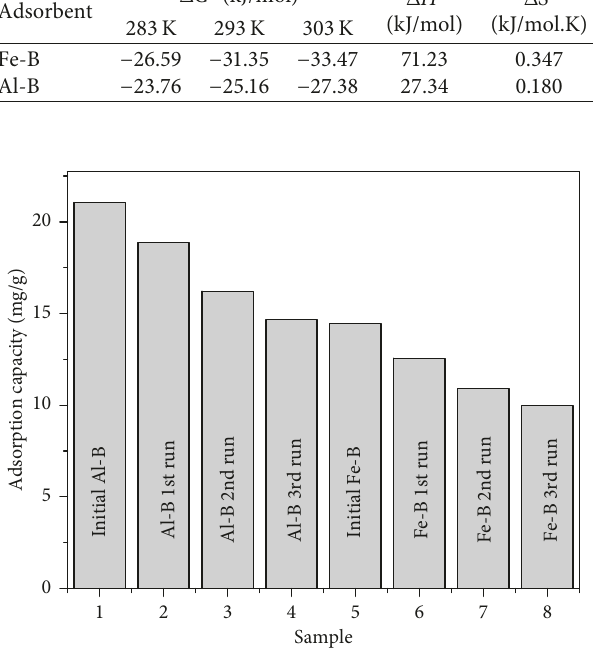
Figure 15: The dependence of adsorption capacity through the reuse of adsorbent ( C o(As) � 24.66mg/L, T � 303K, m � 0.05g, t �